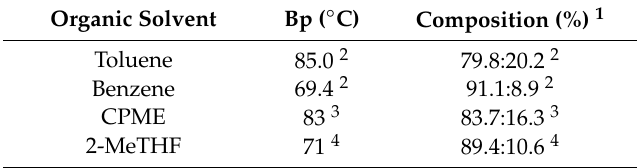
Table 1. Boiling points and percent composition of some organic solvent / H 2 O